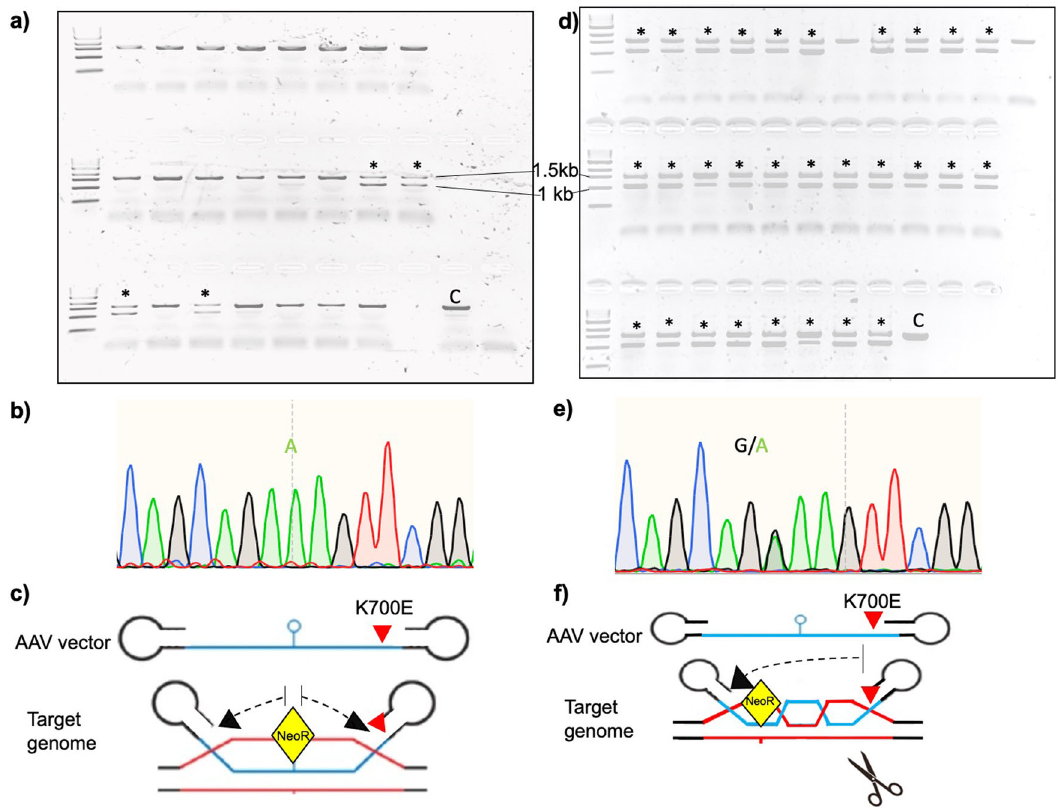
Fig. 3 On-target integration events in G418-resistant clones by rAAV and rAAV-CRISPR/Cas9. a PCR-based identi fi cation of on-target events in SF3B1 alleles using rAAV-based homologous recombination alone strategy. Four of the 25 (16%) G418-resistant clones were PCR positive for on-target integration of the expression cassette (marked with asterisks); C control wild type. b Depicted is the Sanger sequencing of the gDNA target sequence of one of the representative PCR-positive clones generated by rAAV-alone-based HR. The clone did not undergo the desired K700E modi fi cation indicating failure of HR between the target DNA and rAAV in region of the desired modi fi cation ( ∼ 300 bp from the gene-trap cassette integration). c Illustration of the HR event between rAAV vector and genome locus. In the absence of a targeted DSB, HR begins in the intron at the site of obligatory Neo R intron-trap insertion (depicted in yellow) spreading out with decreasing ef fi ciency before falling off due to signi fi cant homology between the rAAV HAs and the host genome. d PCR-based identi fi cation of on-target events in SF3B1 alleles using rAAV + CRISPR/Cas9-based homologous recombination strategy. Thirty-one of the 33 (94%) G418-resistant clones demonstrated on-target integration of the expression cassette (marked with asterisks). e Depicted is the Sanger sequencing of the gDNA target sequence of one of the representative PCR-positive clones generated by rAAV-CRISPR/Cas9-based HR, showing successful single-allele editing of the SF3B1 K700 locus. f The double-stranded break introduced by Cas9 facilitates locus-speci fi c HR of the nascent DNA strand with the rAAV donor template containing the desired